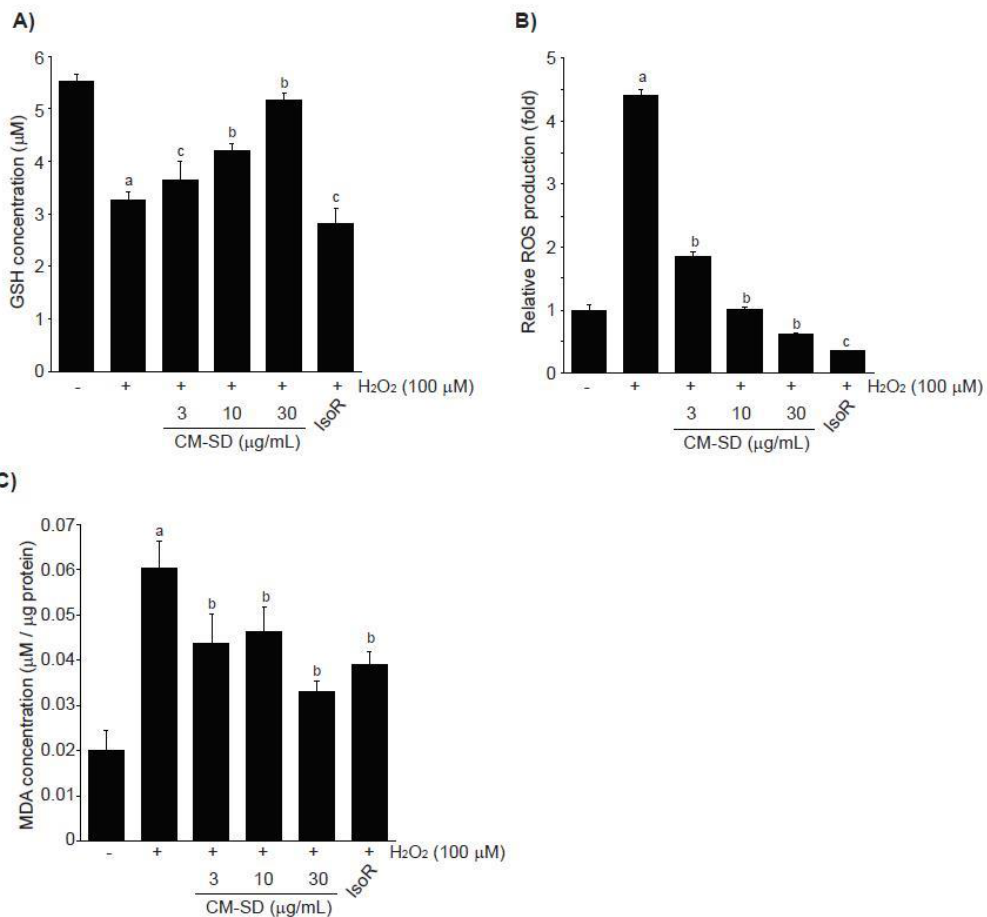
Figure 6. Effect of CM-SD on GSH ( A ), ROS ( B ), and MDA ( C ) levels followed by H 2 O 2 -induced oxidative stress in C2C12 cells. Values are expressed mean ± SD of three separate experiments. Experimental data for GSH and MDA were analyzed by LSD test, and the data for ROS were for Dunnett’s T3 test. a p < 0.01, significant as compared with control; b p < 0.01 and c p < 0.05, significant as compared with H 2 O 2 -treated cells.